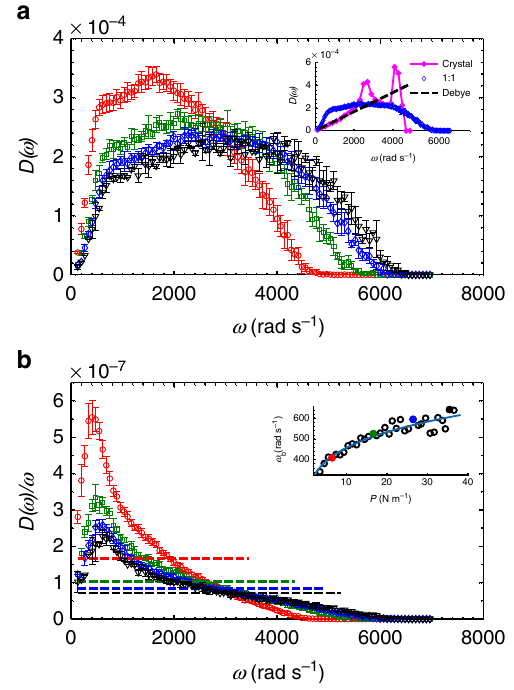
Fig. 2 Density of states and the reduced density of states. a D ( ω ) for pressure (units N m − 1 ) P = 6.54 ( red circles ), 16.69 ( green squares ), 26.5 ( blue diamonds ) and 35.48 ( black inverted triangles ). Here each curve is ensemble averaged over 10 different runs at the same pressure. Inset: comparisons of D ( ω ) values of the disordered system at a pressure of P = 26.5 N m − 1 ( blue diamonds ) with those of the perfect hexagonal lattice ( magenta ) and Debye ’ s model ( black dashed line ). b The corresponding reduced density of states D ( ω )/ ω after normalizing the D ( ω ) in a with Debye ’ s scaling, i.e., ω in 2D. Dashed fl at lines of the same color denote the corresponding Debye ’ s model, which is de fi ned as þ 1 1 g D ð ω Þ = ω ¼ S is the 4 π N v 2 L v 2 T ffiffiffi q G is the transverse sound velocity, ρ ρ is the mass density (mass per unit area), S is the area of the whole system, B is bulk modulus, G is shear modulus, and N is the total number of particles of the system. Inset: the BP frequency ω b vs. the pressure P . Here the blue solid line is a power-law fi tted curve, and the fi tting function is ω = 271.5 P 0.224 . The four fi lled circles of different colors represent the data b points of the four curves of the matching colors shown in the main panel. Here all the error bars denote one SD around the mean value obtained from ∼ 10 realizations of each